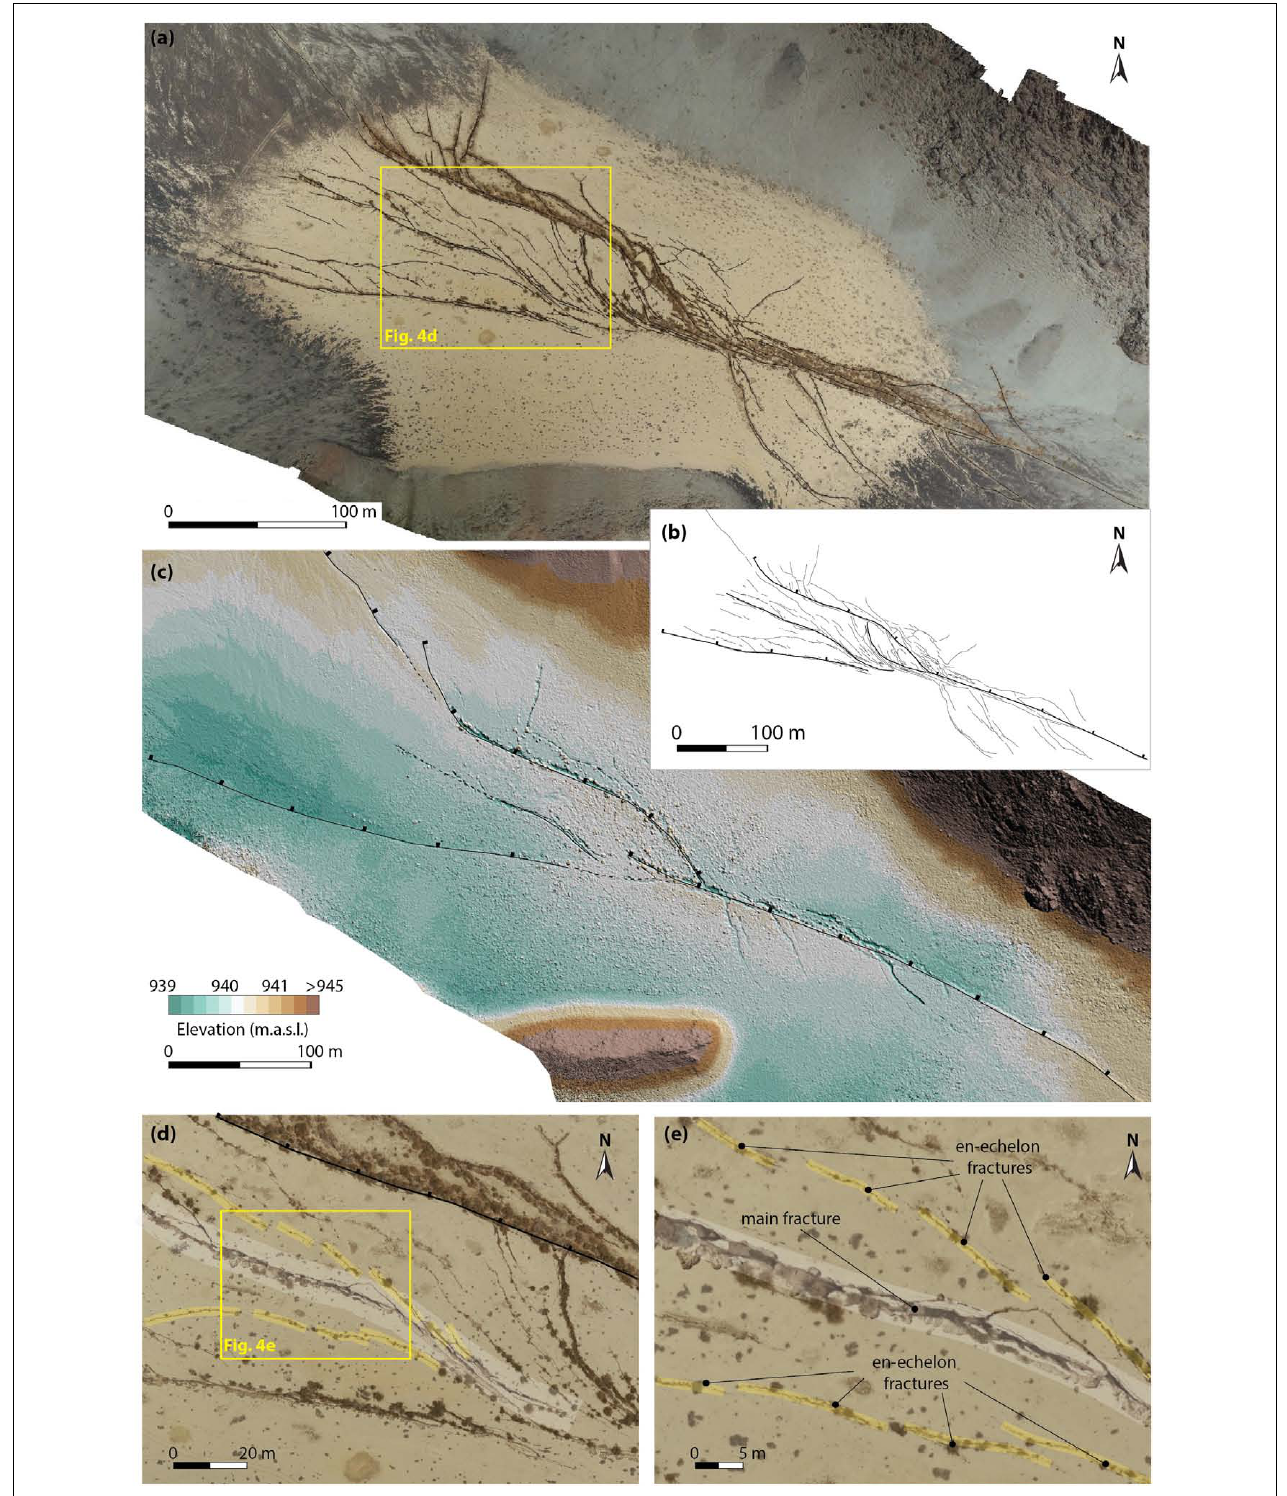
FIGURE 4 | Fracture patterns of the western fault (segment H) where it crosses a silt basin (map coverage shown in Figure 2 ). (a) Drone ortho-photo of the basin that is filled with compacted silt / fine sand having a light brown color. (b) Mapped fracture patterns within the basin with the main faults highlighted as thicker lines. (c) Digital elevation model showing higher vertical displacement at the main faults. (d,e) Close-ups of the central area of the basin with en-echelon fractures highlighted with a transparent yellow color, whereas a major continuous open fracture is highlighted in white.